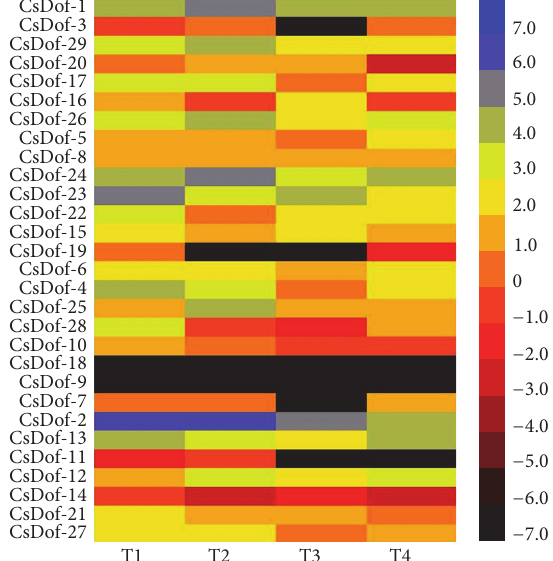
Figure 8: Heat map of Dof genes in four tea plant cultivars. T1 represents “Yunnanshilixiang,” T2 represents “Chawansanhao,” T3 represents “Ruchengmaoyecha,” and T4 represents “Anjibaicha.” Color scores were normalized by the log 2 transformed counts of RPKM